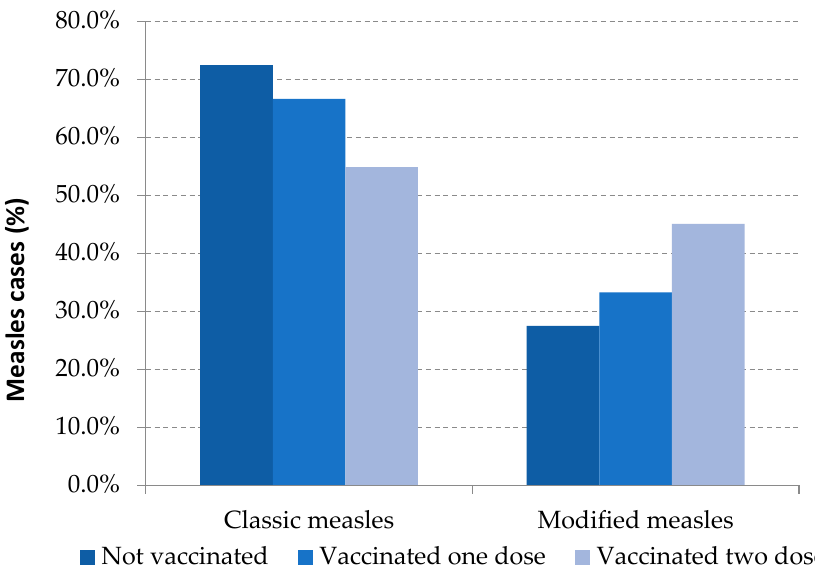
Figure 2. Measles clinical presentation and vaccination status. Spain, 2014–2020.Source: National Epidemiological Surveillance Network, National Centre for Epidemiology, ISCIII. Table 4. Measles cases reported in healthcare settings, by professional group and vaccination status. Spain, 2014–2020. Healthcare Workers